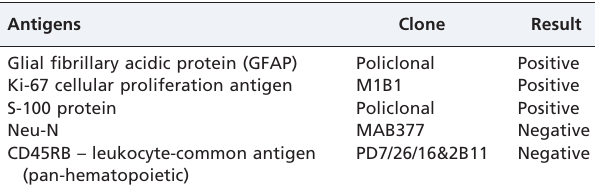
Table 1 - Antigens that were used for the